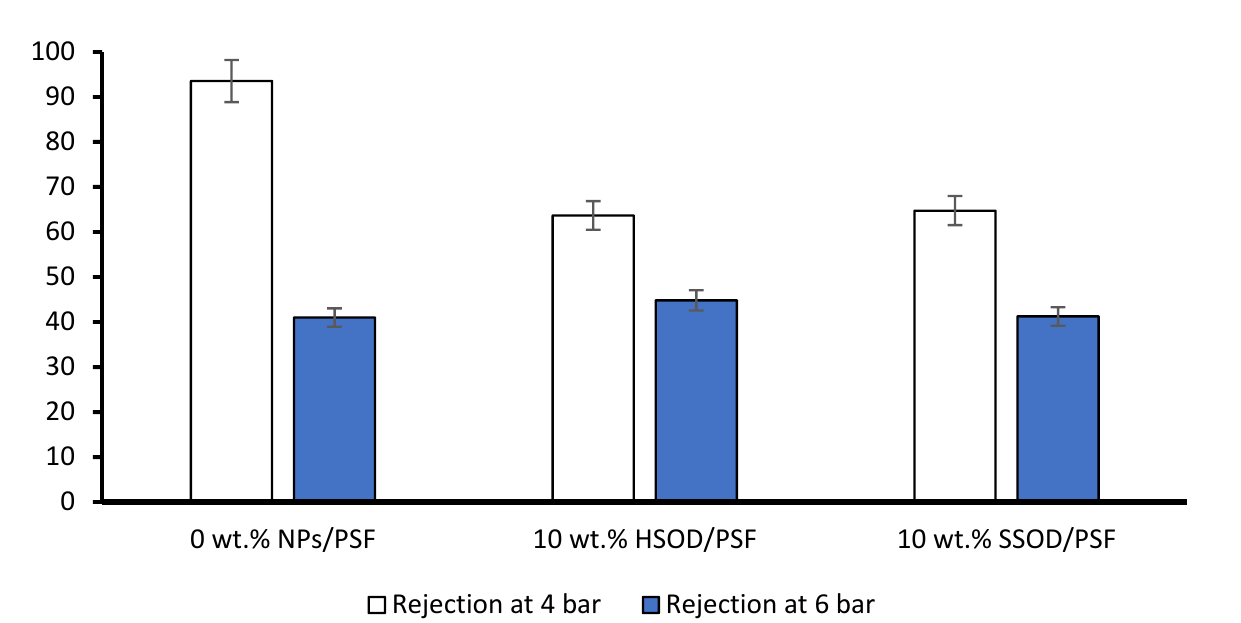
10 wt.% SSOD/PSF Rejection at 4 bar Rejection at 6 bar Figure 10. Phenol rejection from 0 wt.% NPs/PSF, 10 wt.% HSOD/PSF, and 10 wt.% HSOD. Table 2. The comparison of the performance between HSOD/PSF and SSOD/PSF and literature. Membrane Permeate Flux (L/m 2